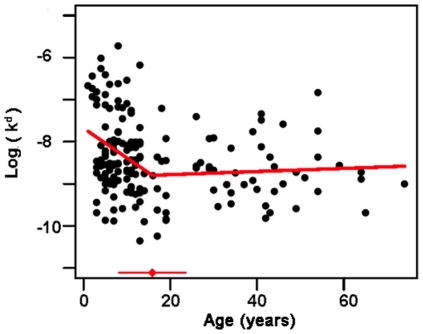
Natural logarithm of kd variation with age in the Tanzanian population.Affinity variation with age for samples from Tanzania, shown for binding to AMA1-D10 where the break-point was determined to be 16 years of age. The solid line is the estimated fit from the linear normal model. The red dot with a line at the bottom indicates the 95% confidence interval for the breakpoint.